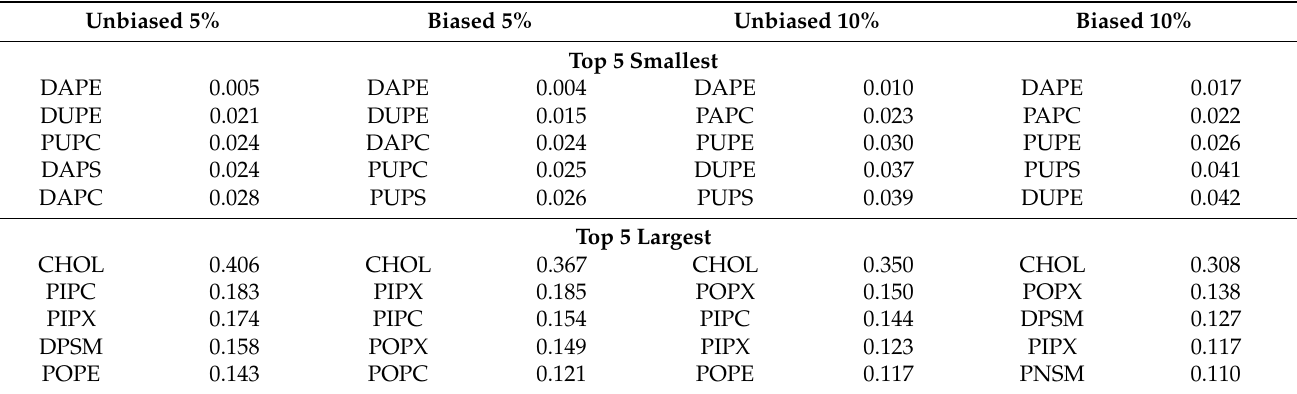
Figure 3. ( a ) Top view of the system; fullerenes are shown in red. The blue square indicates the enlarged region. ( b ) Top view of the enlarged region showing the grid. Molecules other than fullerenes are not shown for clarity. ( c ) The corresponding ‘shadow’ matrix. Black (assigned the value of 1) means there is at least one fullerene in the grid space; white (the value of 0) means there is no fullerene present in the grid space. Table 2. Mean square error (MSE) values comparing the average fullerenes and each type of lipid tail location for the inner and outer leaflets together over the last 5 µ